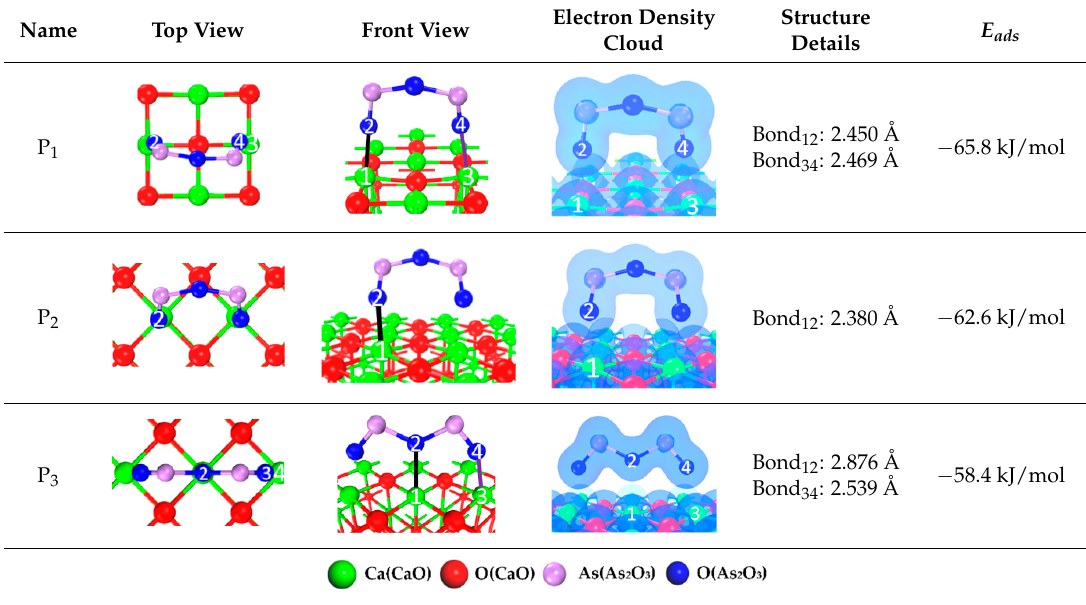
Table 2. Stable physisorption structures, adsorption energy, electron density cloud, and E ads .